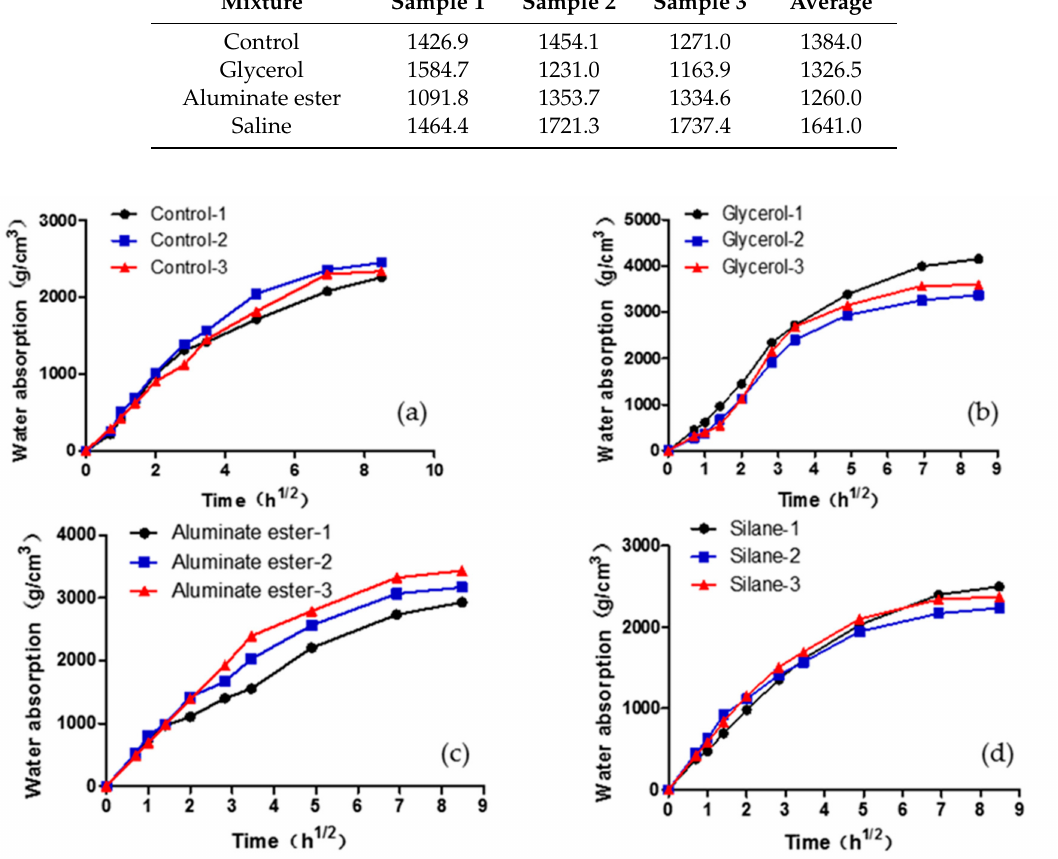
Figure 7. Capillary water absorption curve of ( a ) control mixture, ( b ) glycerol mixture, ( c ) aluminate -ester mixture, and ( d ) silane